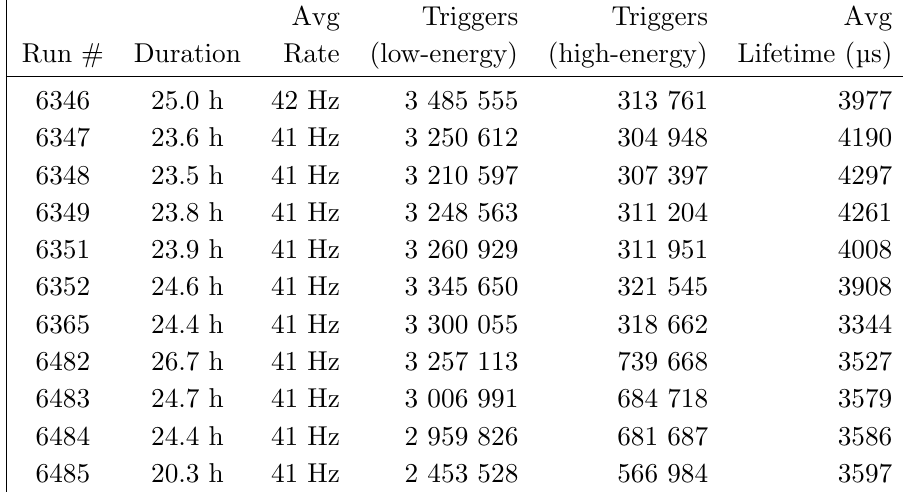
Table 1 . Summary of data analyzed in this